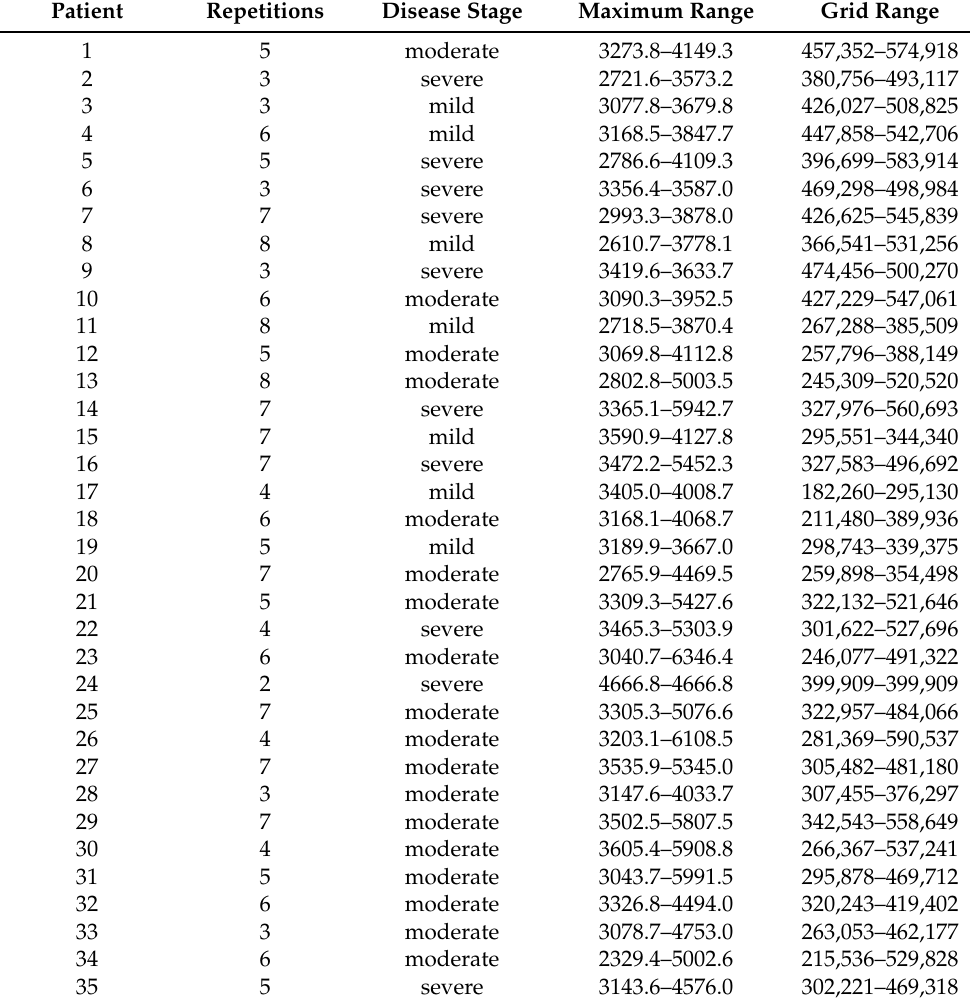
Table 2. Synopsis of the studied dataset. For each of the 35 patients (column i), labeled from 1 to 35, it is displayed the number of repeated measurements (column ii), the disease stage of the patient (column iii), the range, among the repetitions for each patient, of the time domain upper-bounds, in seconds, (column iv) and the range, among the repetitions for each patient, of the number of grid points (column v).